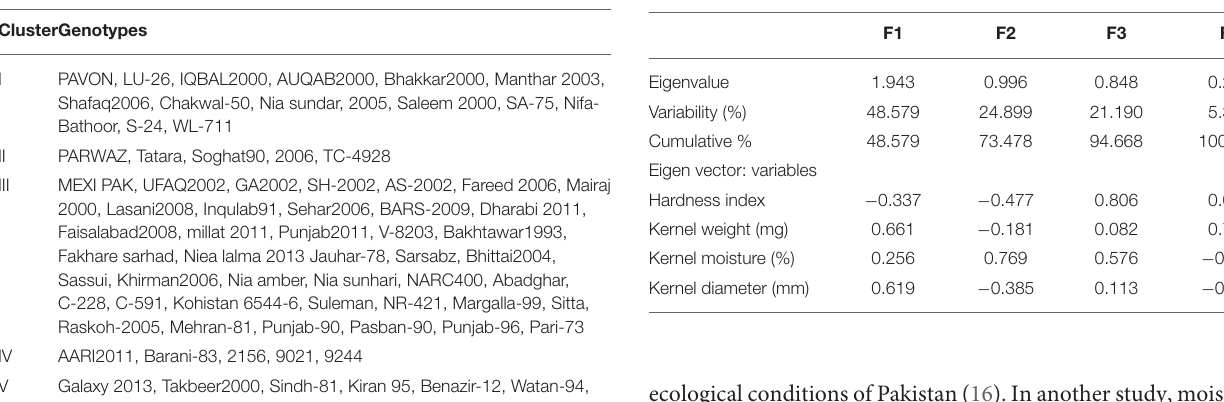
TABLE 9 | Principal component analysis for different quality parameters regarding single kernel characteristics in wheat